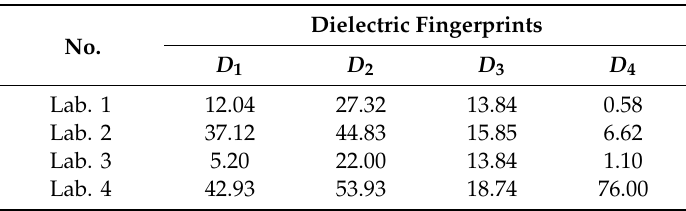
Table 7. Dielectric fingerprints of the lab samples.